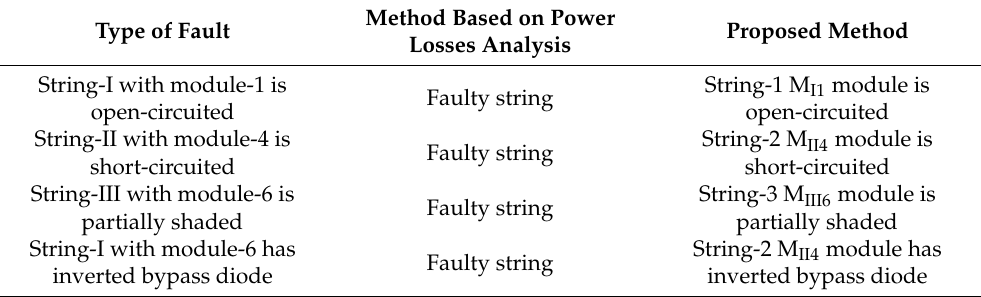
Table 3. Comparative results between the proposed method and the one presented in Ref.